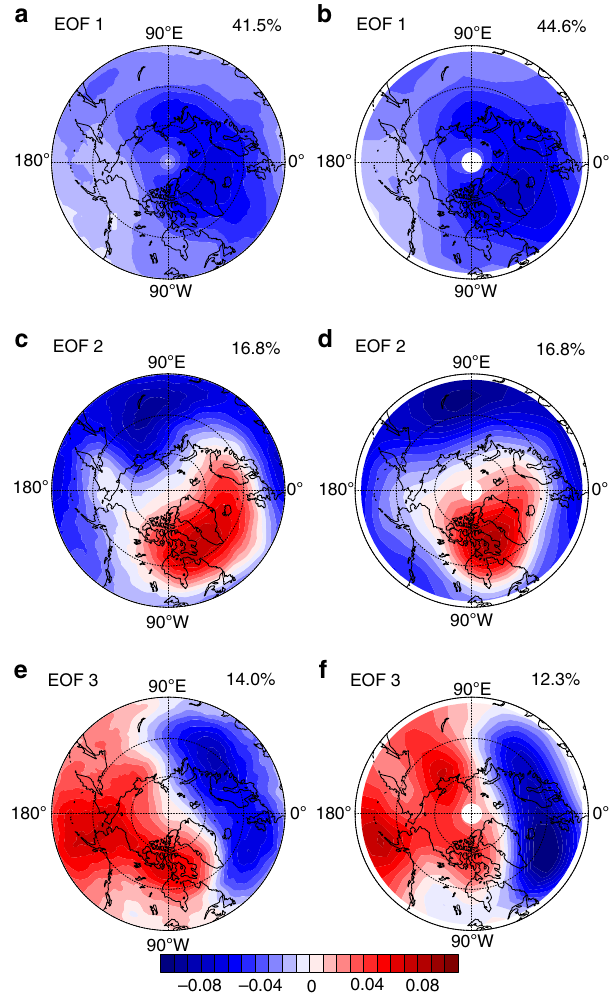
Fig. 1 EOF of total column ozone over the Northern Hemisphere extratropics. Spatial patterns of EOF1, EOF2 and EOF3 of February mean total column ozone (TCO) over 45 – 90°N derived from a , c , e MSR2 data and b , d , f SLIMCAT full chemistry simulation for the period 1980 – 2012. The percentage of explained variance is shown in the top right of each plot. The minimum latitude of the polar stereographic projections is 45°N. The values in 1987, 2006 and 2009 are not included for EOF analysis because the polar vortex broke up and its shape was distorted during February in these years